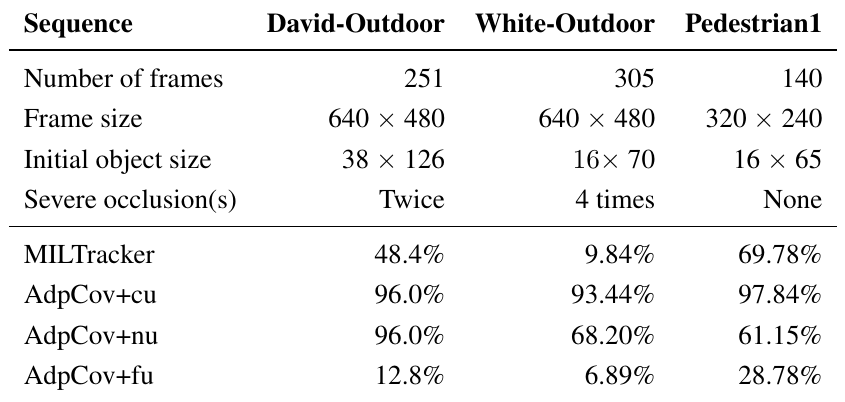
Table 2. Information of the sequences and the tracking performances in terms of PCF. Sequence